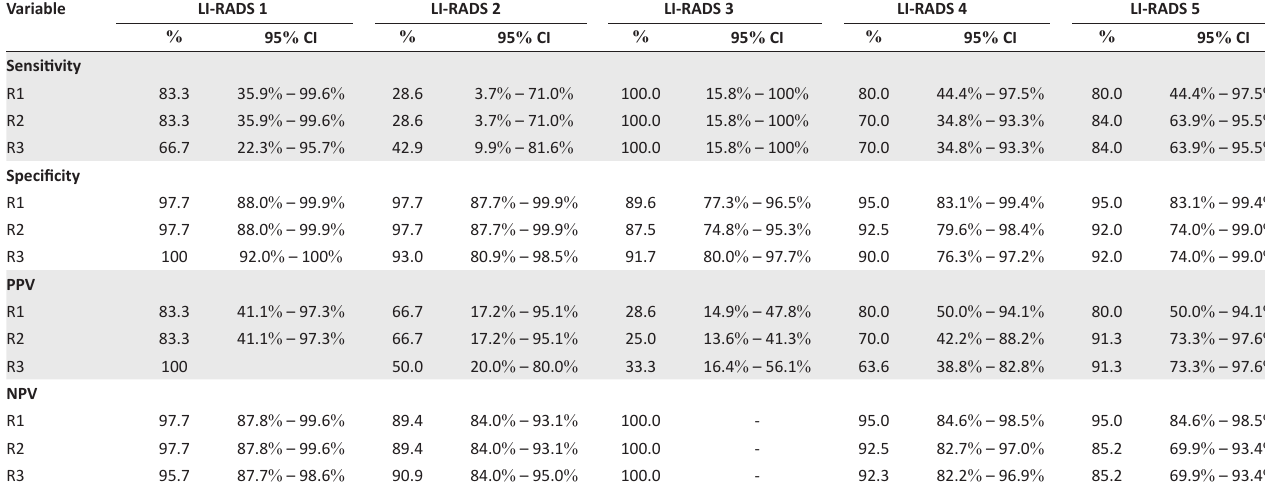
TABLE 1: The sensitivity, specificity, positive predictive value and negative predictive value per Liver Imaging Reporting and Data System category for each reader.